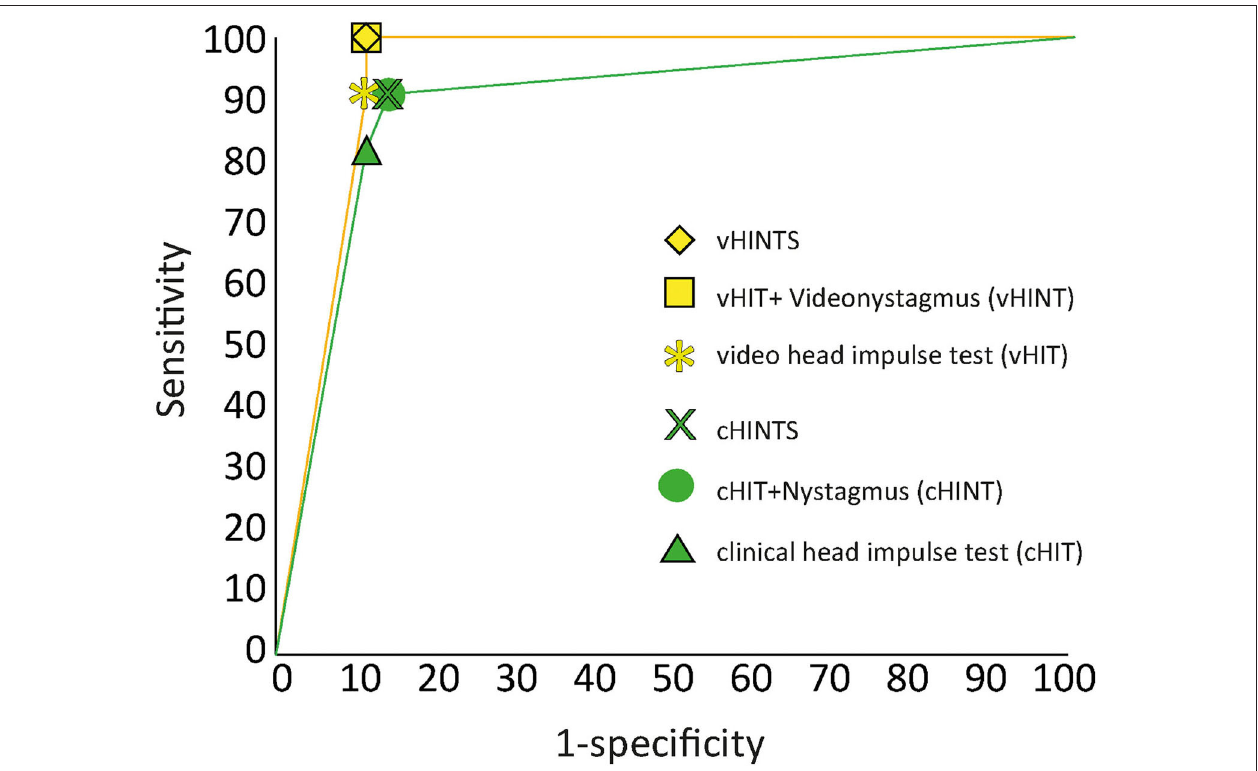
FIGURE 5 | ROC analysis for stroke diagnosis of clinical (green) vs. video “HINTS” (yellow). We report here the sensitivity/specificity of the head impulse tests alone (HIT) or in conjunction with the other two components of the “HINTS” battery (HINT or HINTS).